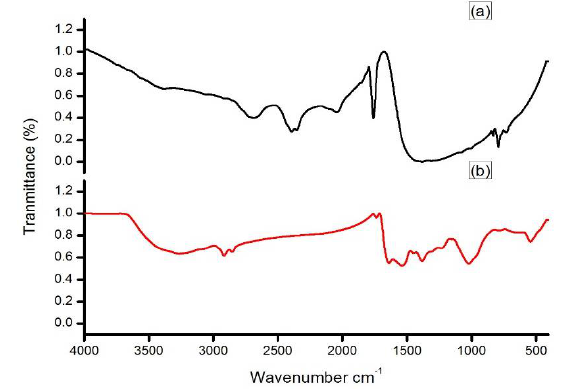
Figure 2. The FTIR spectrum of the silver nanoparticles derived from marine Streptomyces sp. Al-Dhabi-87. ( a ) FTIR spectrum of Siver nitrate ( b ) FTIR spectrum of nanoparticles.